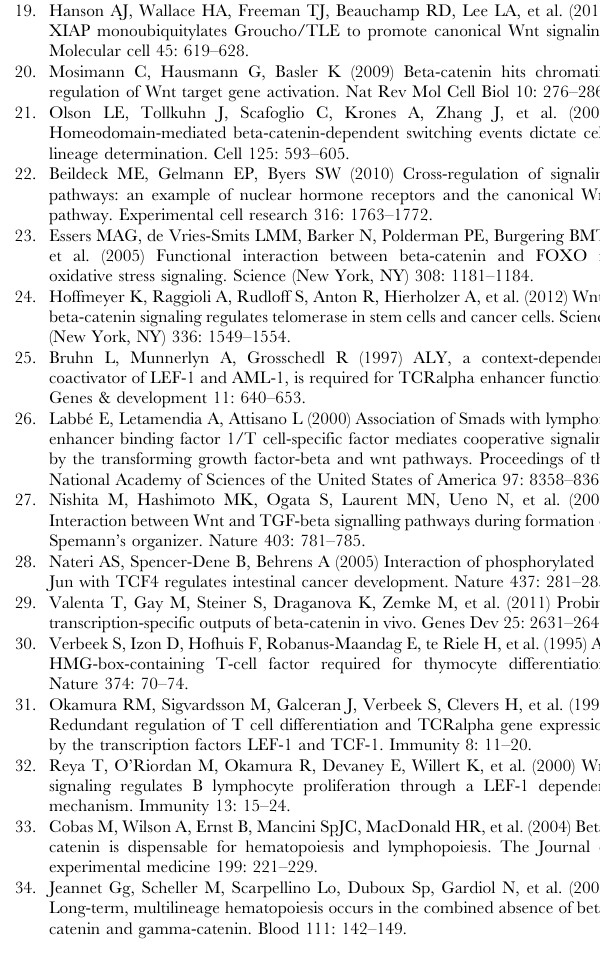
antibodies. (PDF) Figure S8 Interaction between endogenous LEF1 and ATF2/7 in hematopoietic tumor cells. 2 mg of Lysate from K562 (A) or Ramos (B) cells was immunoprecipitated using 10 ug of anti-LEF1 or control antibody, followed by immunoblot using the indicated antibodies. The band corresponding to immunoprecipitated LEF1 ( , 55 kDa) was masked by the IgG heavy chain used for the